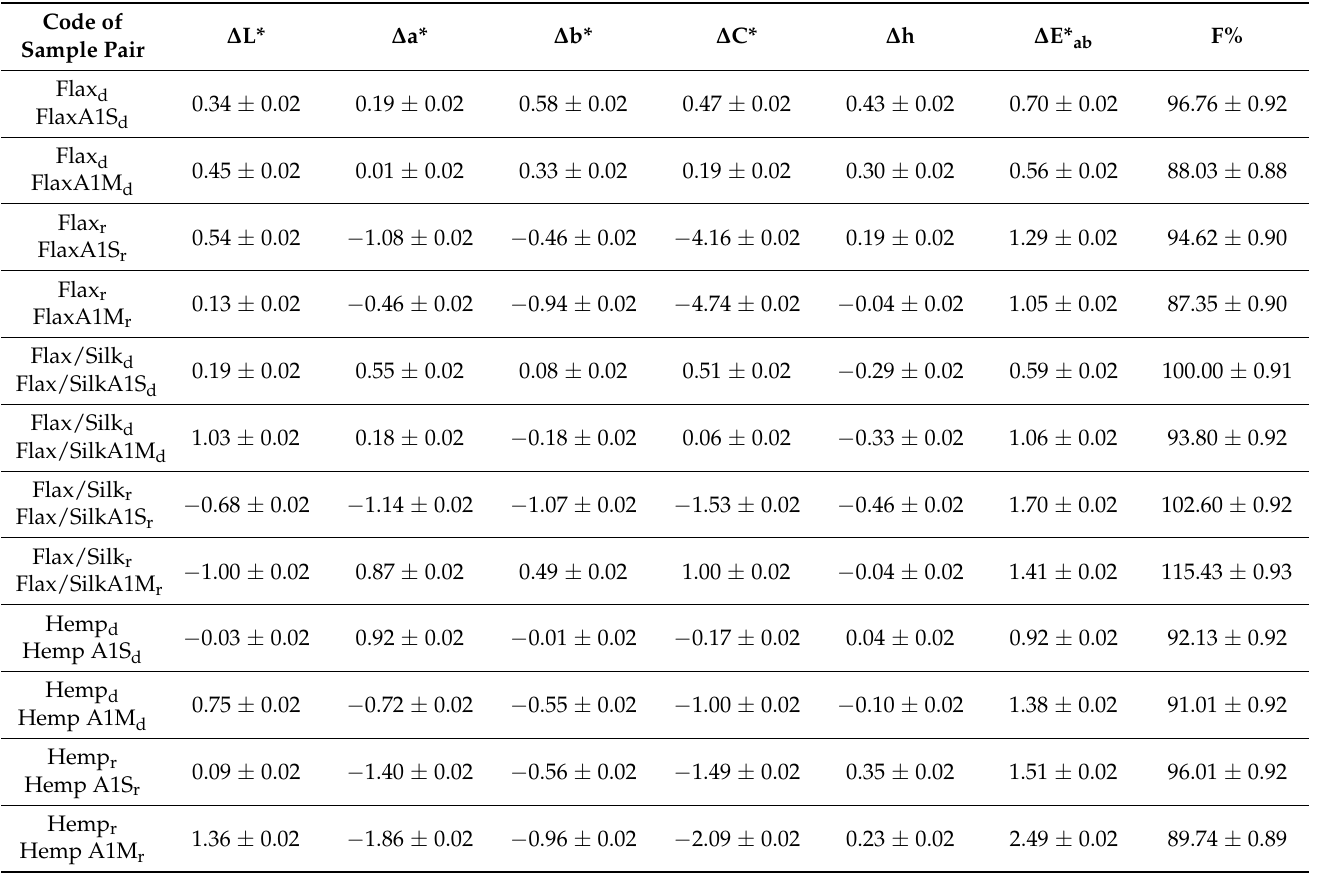
Table 3. The differences of CIE L * a * b * colour coordinates and a degree of fixation of the absorbed dye of unwashed and washed fabrics.